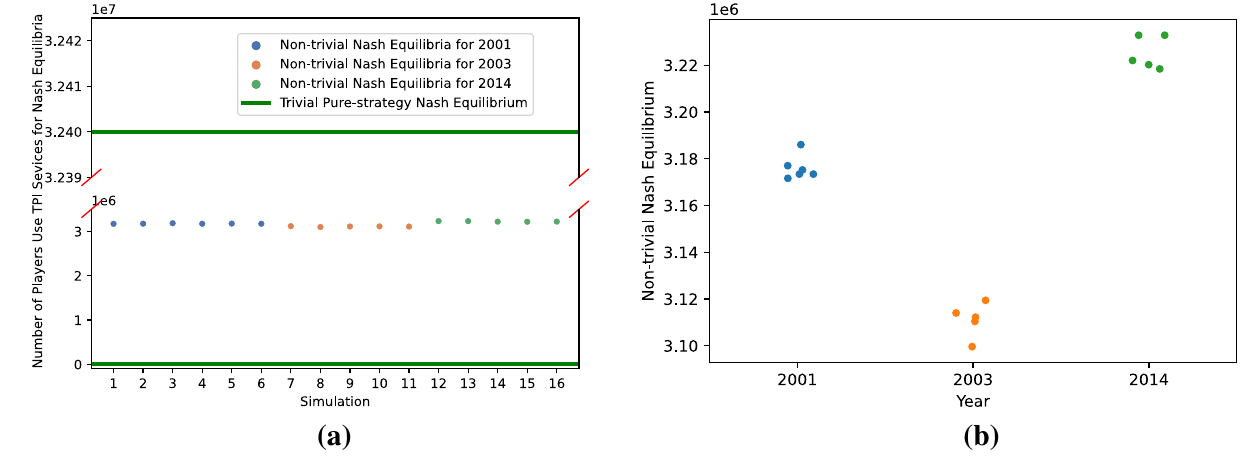
Figure 3. Simulation results when the parametric setting follows Westin’s privacy segmentation. ( a ) The distribution of Nash equilibria when the distribution of c i follows Westin’s categories for different years; ( b ) Interior Nash equilibria found in 50 simulations under different parametric